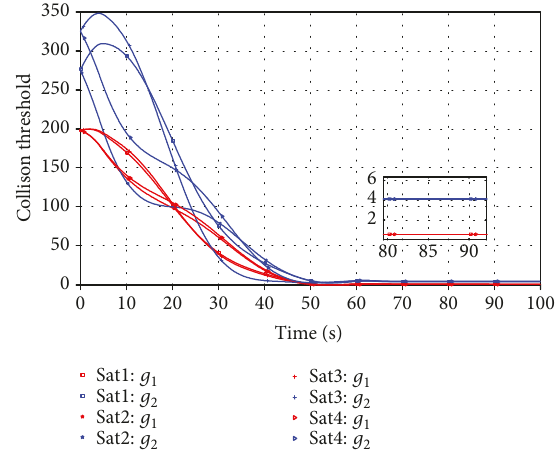
Figure 10: Three-dimensional plot of the transfer trajectories with the servicer at di ff erent initial positions.